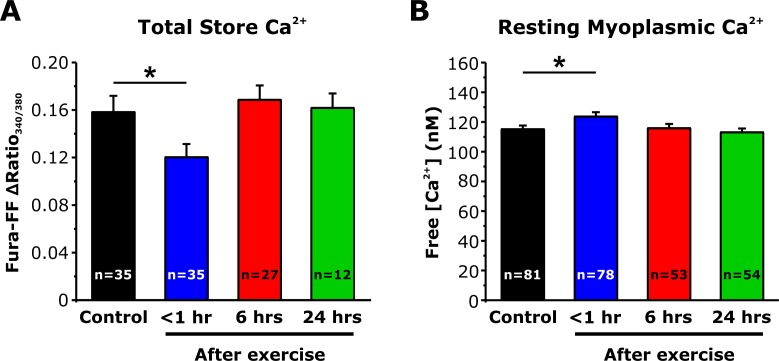
Effect of exercise on total Ca2+store content and resting myoplasmic Ca2+ concentration.(A) Quantitative analysis of the total Ca2+ store content elicited during application of ICE (10 µM ionomycin, 30 µM CPA, and 100 µM EGTA) in fura-FF-loaded FDB fibers. (B) Quantitative analysis of resting myoplasmic Ca2+concentration recorded in fura-2-loaded FDB fibers. Data shown for control and <1 hr after acute treadmill exercise are replotted from Figure 5D and E to enable comparison with measurements taken from mice 6 and 24 hr after exercise. Numbers in bars and parentheses (n) reflect the number of FDB fibers analyzed. Number of mice used in A: Control, n = 4; <1 hr after exercise, n = 4; 6 hr after exercise, n = 3; 24 hr after exercise, n = 3. Number of mice used in B: Control, n = 5; <1 hr after exercise, 5; 6 hr after exercise, n = 4; 24 hr after exercise, n=4; *p<0.05. Data are shown as mean ± SEM.